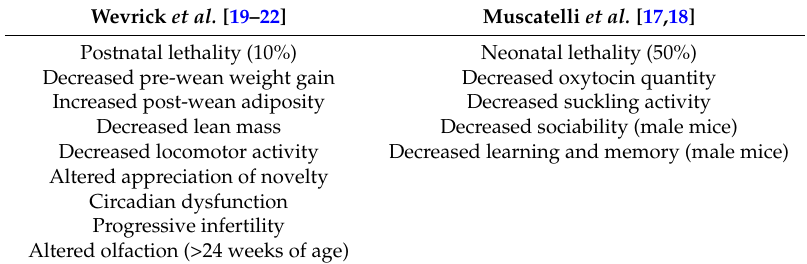
Figure 1. Prader-Willi syndrome and Schaaf-Yang syndrome share common overlapping symptoms, yet have important distinct features. While none of the symptoms listed in this figure may be exclusive to any one condition, the figure attempts to highlight those features that have particularly high prevalence in the respective disorders. Only phenotypes of >50% prevalence for the respective disorder are listed. 1 , defined by gene deletions in the 15q11-q13 chromosomal region; 2 , defined by truncating point mutations of the MAGEL2 gene. Table 2. Comparison of reported phenotypic manifestation of Magel2 -null mouse models.